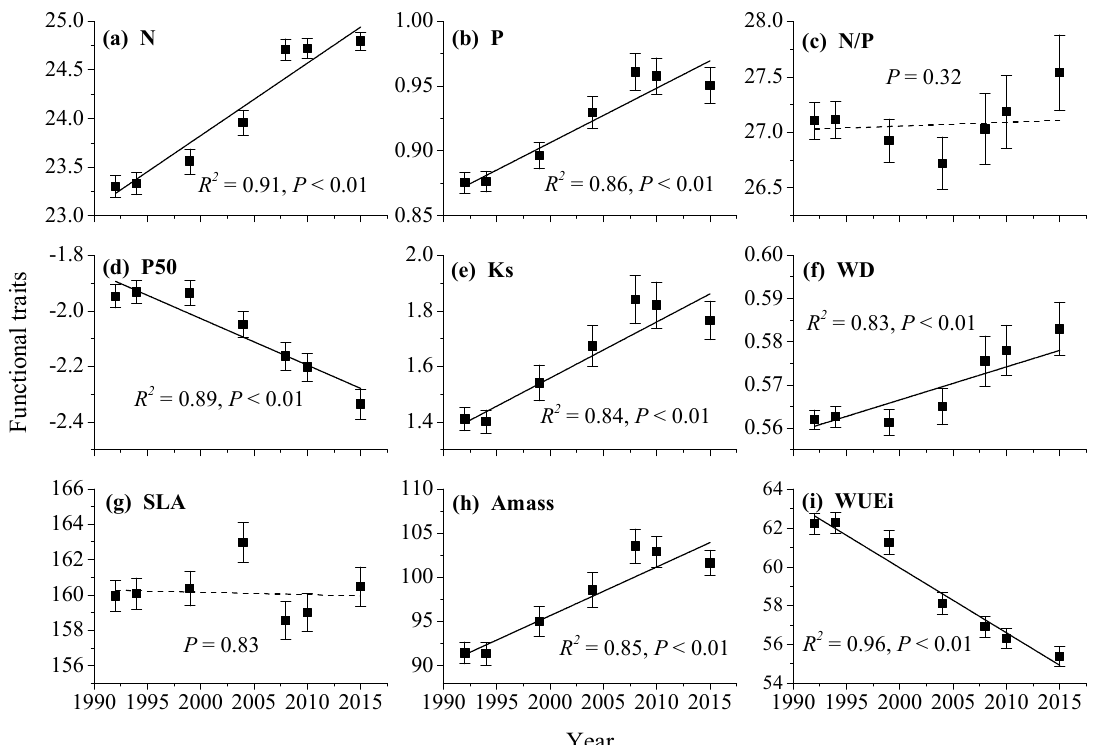
Figure A1. Temporal trends of quadrats’ functional traits (based on abundance) in the monsoon evergreen broad-leaved forest. Note: Nmass, leaf nitrogen concentration per unit mass (mg g − 1 ); Pmass, leaf phosphorus concentration per unit mass (mg g − 1 ); N / P, leaf nitrogen to phosphorus ratio per unit mass; P50, the pressure causing 50% loss of stem hydraulic conductivity (MPa);